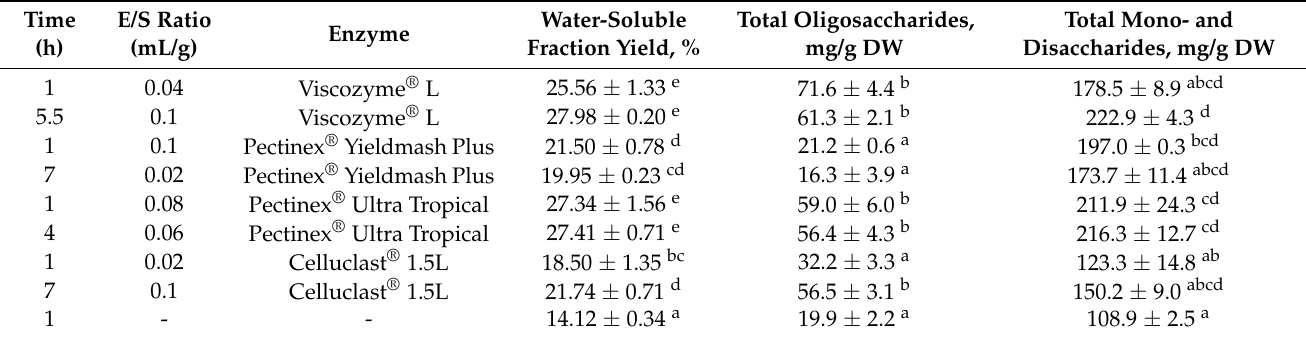
Table 2. Water-soluble fraction yield and saccharide composition of cranberry pomace after enzymatic